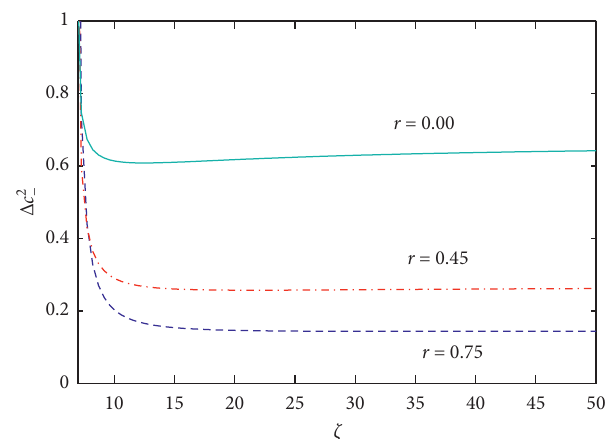
Figure 3: Plots of the minus quadrature variance (equation (47)) versus ζ for κ � 0 . 8, A � 2 . 5, and ε � 0 . 20 and for different values of r